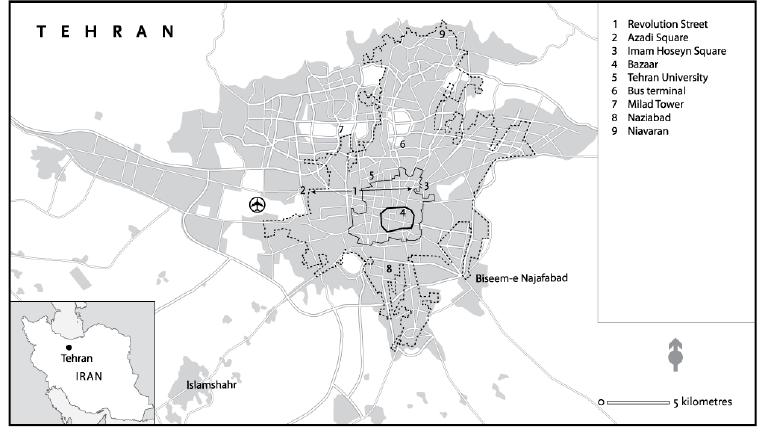
Figure 3. Tehran metropolitan area (adopted from [51]).